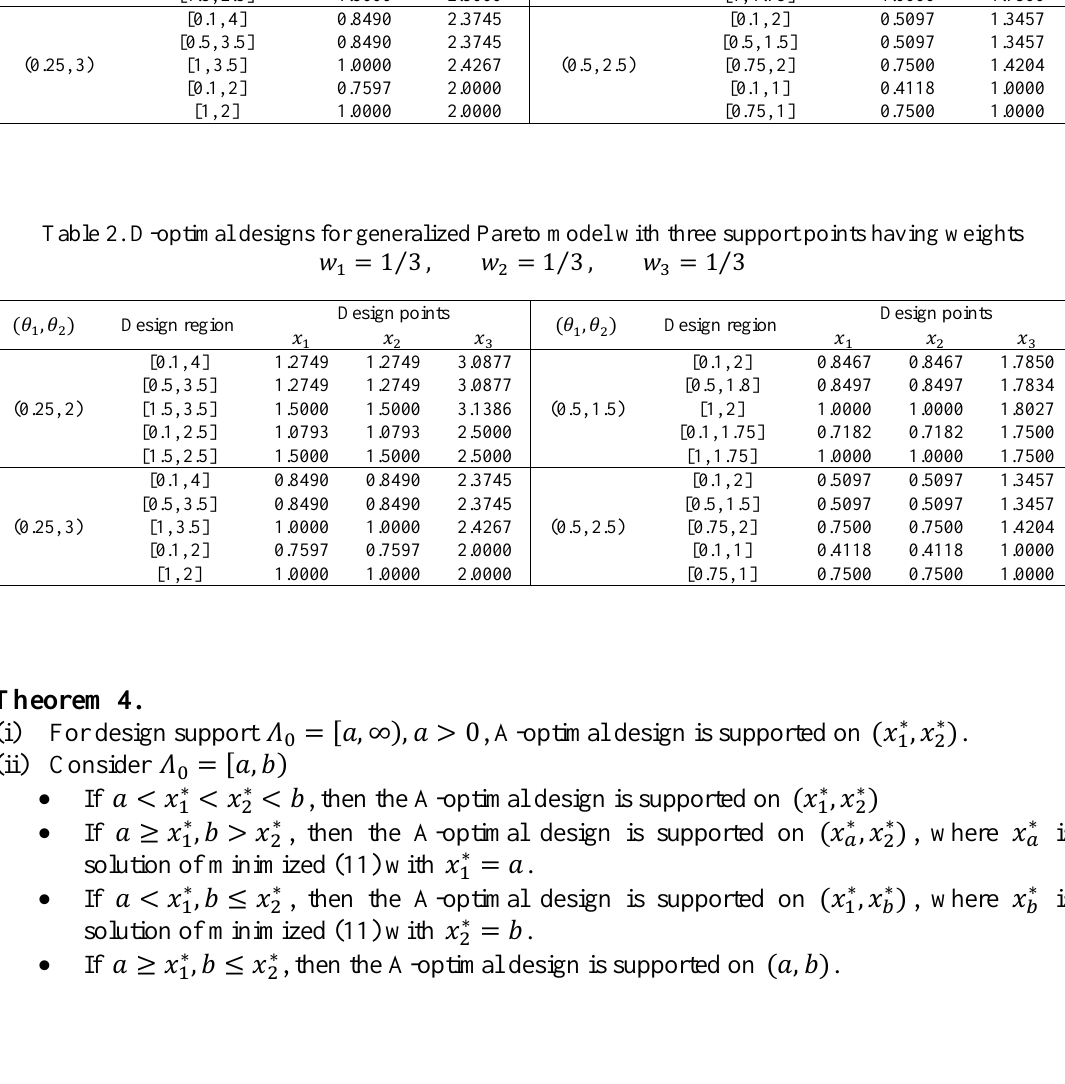
Table 1. D-optimal designs for generalized Pareto model with two support points having weights